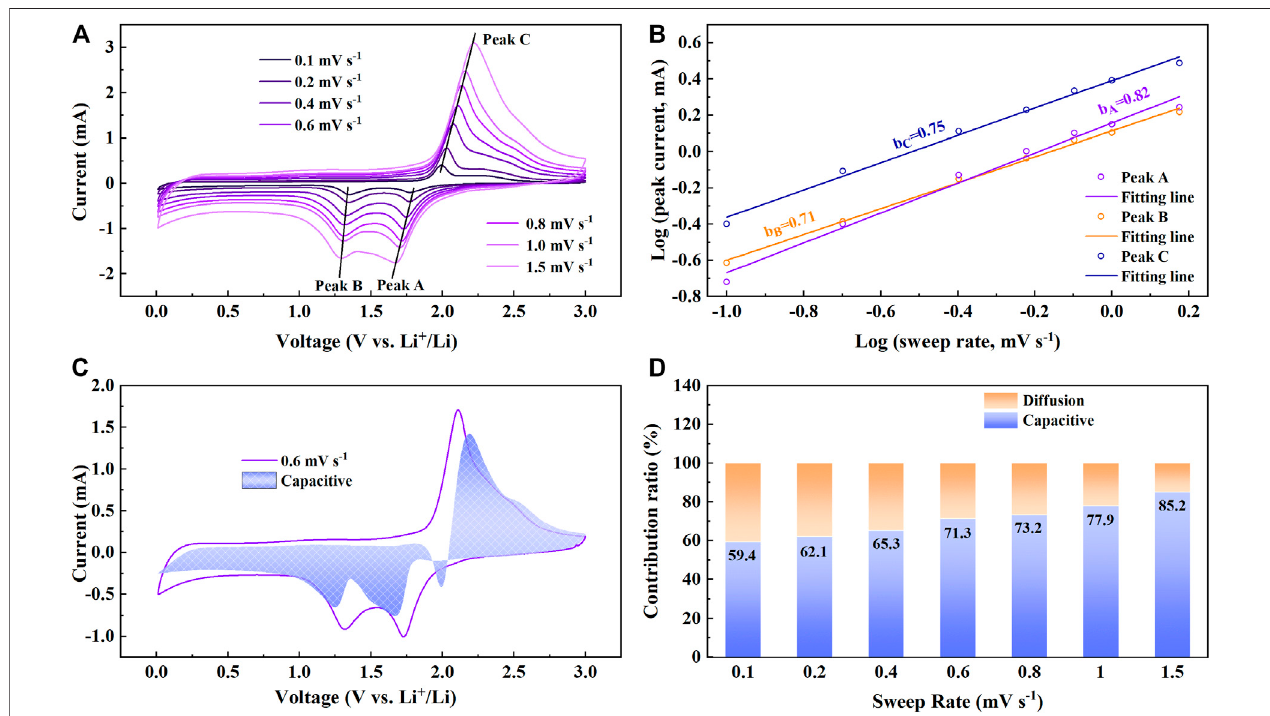
FIGURE 6 | (A) CV curves at different sweep rates. (B) The corresponding plots of log( i ) vs. log( v ) at three redox peaks. (C) The CV curves and the voltage distribution (shaded part) at the sweep rate of 0.6 mV s − 1 . (D) Contribution ratio of capacitive at various sweep rates.